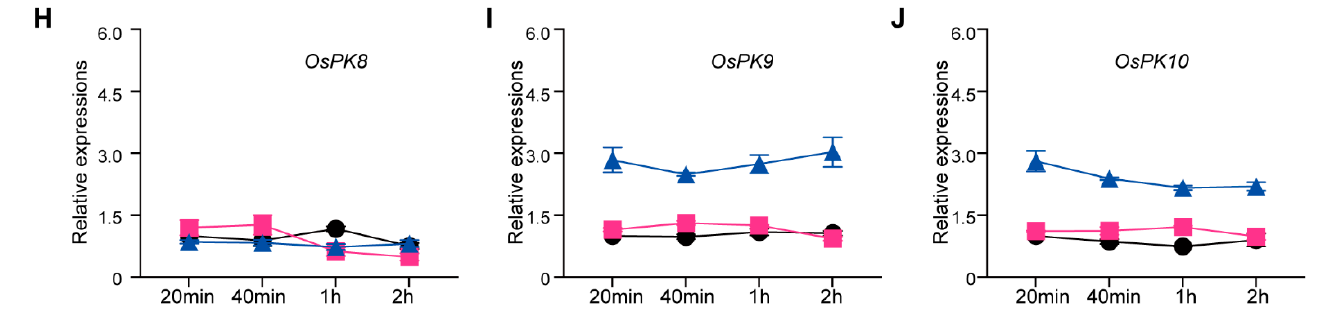
Figure 5. Prediction of promoter element of PK genes in rice and PK gene responses to abscisic acid. ( A ) ARE is a cis -acting regulatory element that is essential for anaerobic induction. MBS is an MYB binding site that is involved in drought inducibility. W-box and WUN-motif represent stress-related cis -elements. ABRE is an abscisic-acid-responsive element. CGTCA-motif and TGACG-motif are the cis -acting regulatory elements involved in MeJA responsiveness. LTR is a cis -acting element that is involved in low-temperature responsiveness. Box 4 and Sp 1 are part of a conserved DNA module involved in light responsiveness. AuxRE and TGA are auxin-responsive elements. GARE-motif is a gibberellin-responsive element. ( B – J ) The relative expression levels of PK genes ( OsPK1 , OsPK2 , OsPK3 , OsPK4 , OsPK5 , OsPK6 , OsPK8 , OsPK9 , and OsPK10 ) after treatment with ABA. Black lines represent the group without the addition of abscisic acid. Pink lines represent the treatment group with the addition of 5 mM abscisic acid. Blue lines represent the treatment group with the addition of 50 mM abscisic acid. Error bars indicate the means ± SDs of three individual